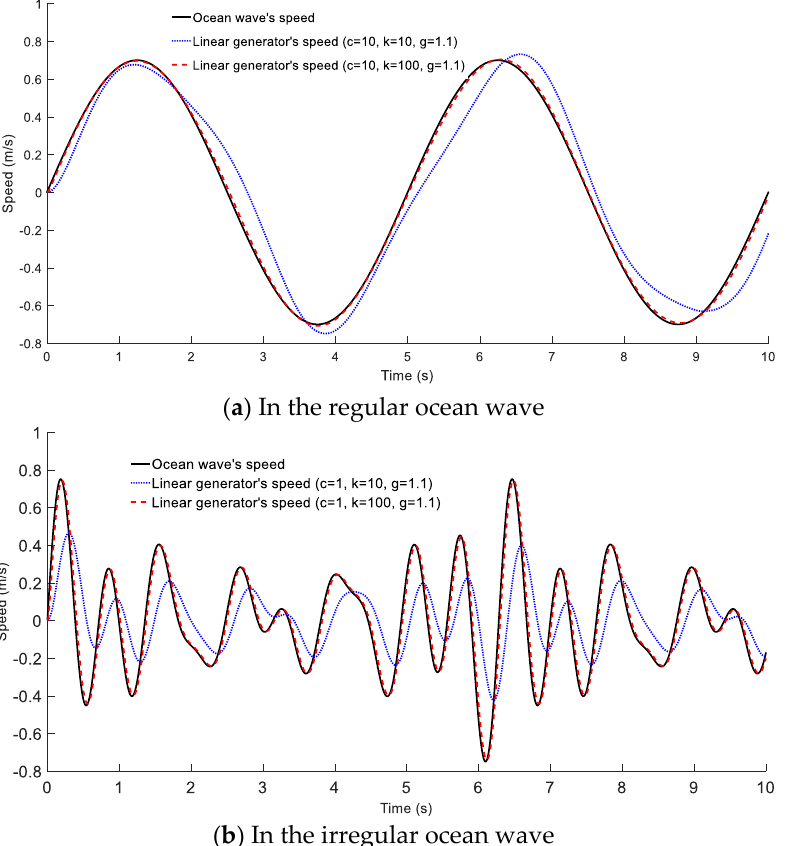
Figure 11. Optimized control of double-buoy